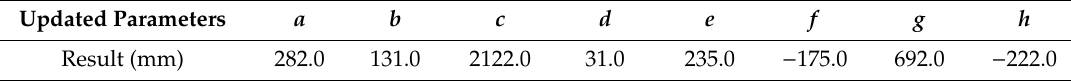
Figure 6. The statistical results of 30 ELGA experiments: population size = 30, iterations number = 50. Table 1. The updated geometric parameters of the kinematics model.